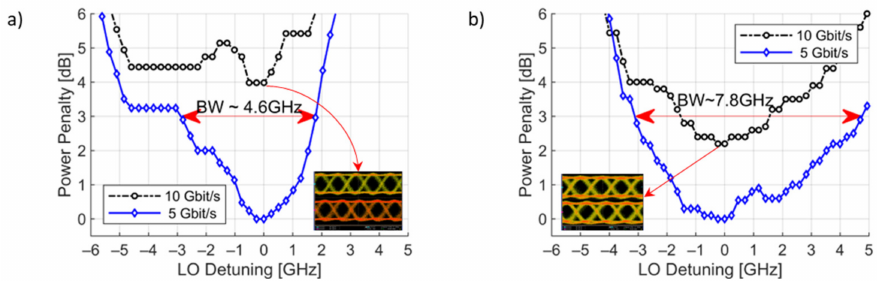
Figure 8. Power penalty inferred from the sensitivity of the BER 1E-3 as a function of the LO frequency detuning for 10 and 5 Gbps. ( a ): Transmitter is a commercial C-Band DML; ( b ): Transmitter is a commercial L-Band